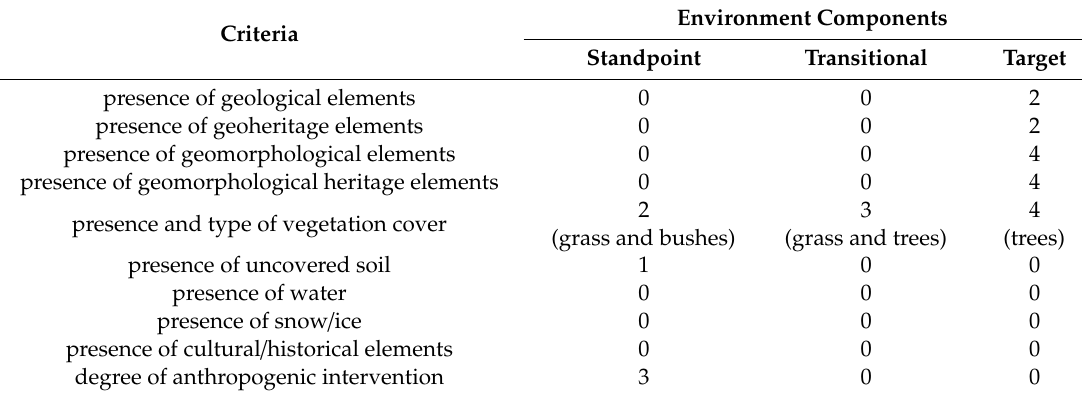
Table 2. Environment of the Soldatskij Pass geosite.